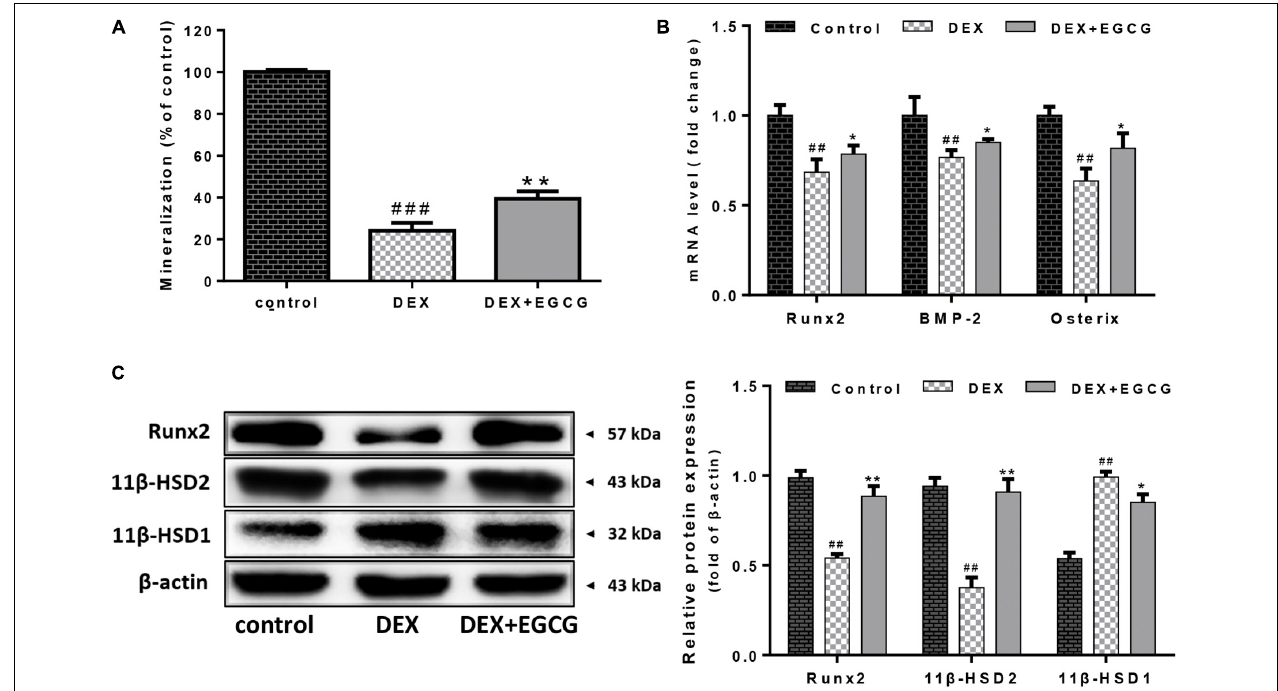
FIGURE 3 | Effects of EGCG on DEX-induced differentiation and 11 β -HSD activity in primary osteoblasts. (A) Mineralization of cells was inhibited by DEX, but pretreatment with EGCG reduced this effect. (B) Expression levels of representative osteogenic differentiation transcriptional factors (Runx2, BMP-2, and Osterix) were analyzed by real-time PCR. (C) Expression of 11 β -HSD and Runx2 was measured by Western blot, and quantitated levels of protein were statistically evaluated, as shown in the column. The data were expressed as the mean ± SD . ## P < 0.01, ### P < 0.001 vs. control and ∗∗ P < 0.01, ∗ P < 0.05 vs.